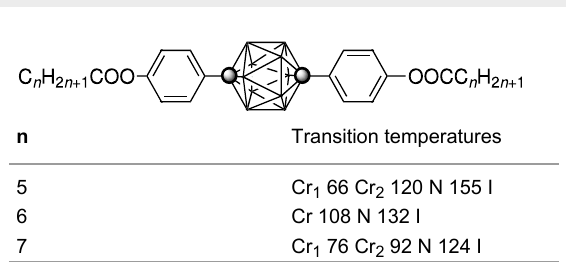
Table 2: Transition temperatures (°C) for 16A[n] . a